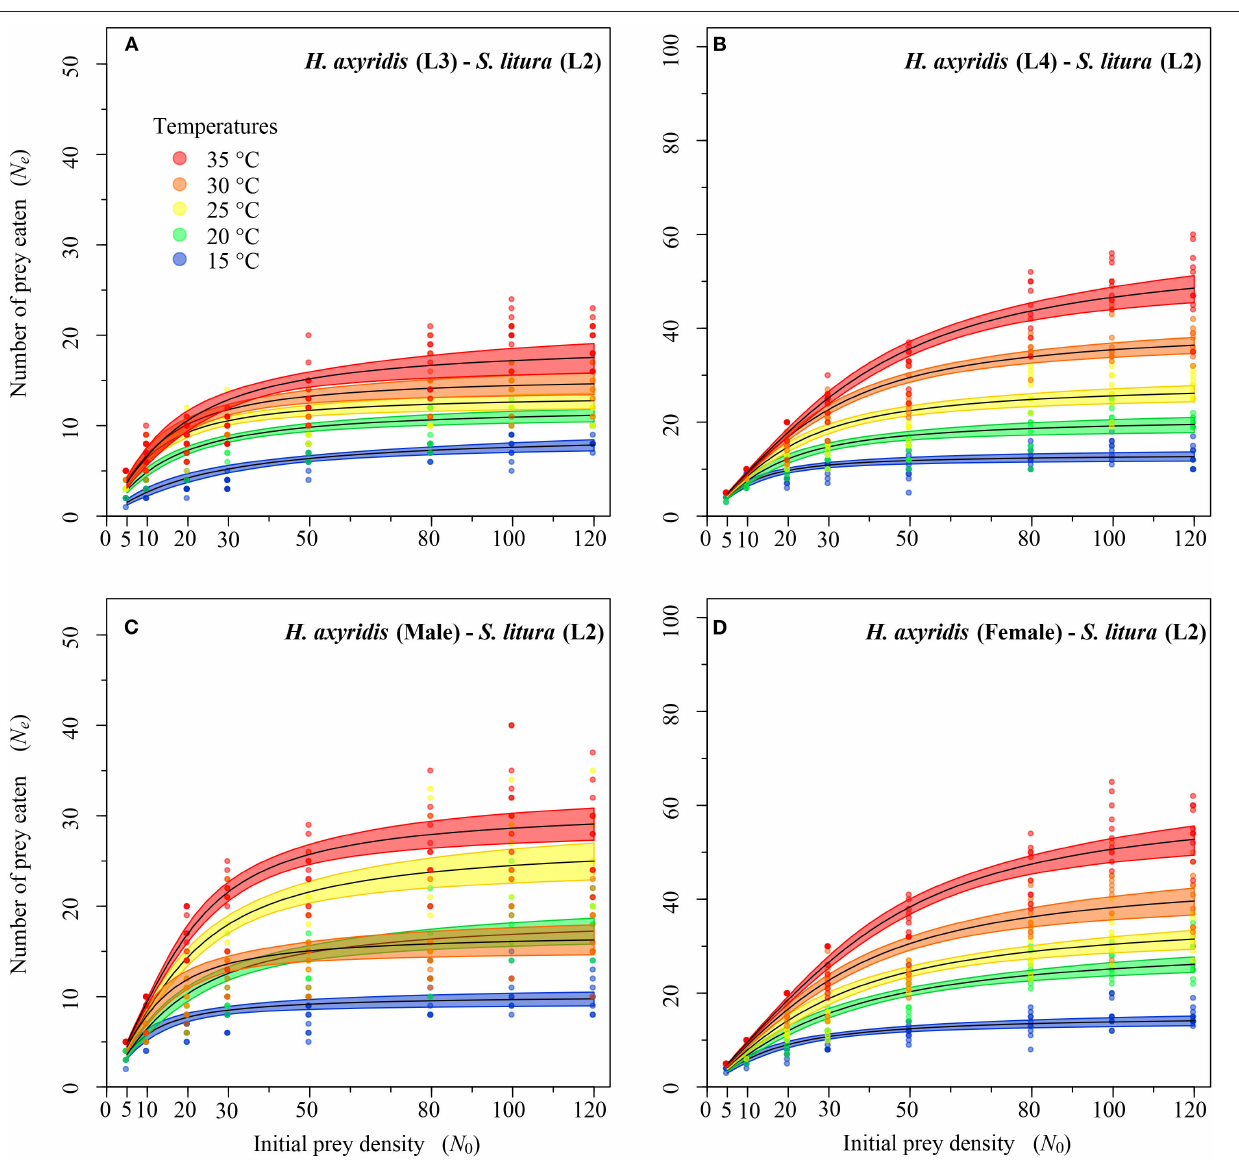
FIGURE 4 | Functional response of different stages of Harmonia axyridis [L3-Female ( A–D )] foraging on 2nd instar of Spodoptera litura . Dots represent the observed numbers of prey consumed at each initial prey density, and black lines were predicted by the Roger’s random predator equation, while the shaded areas represent the limits of the 95% confidence intervals. Number of replications (N) =